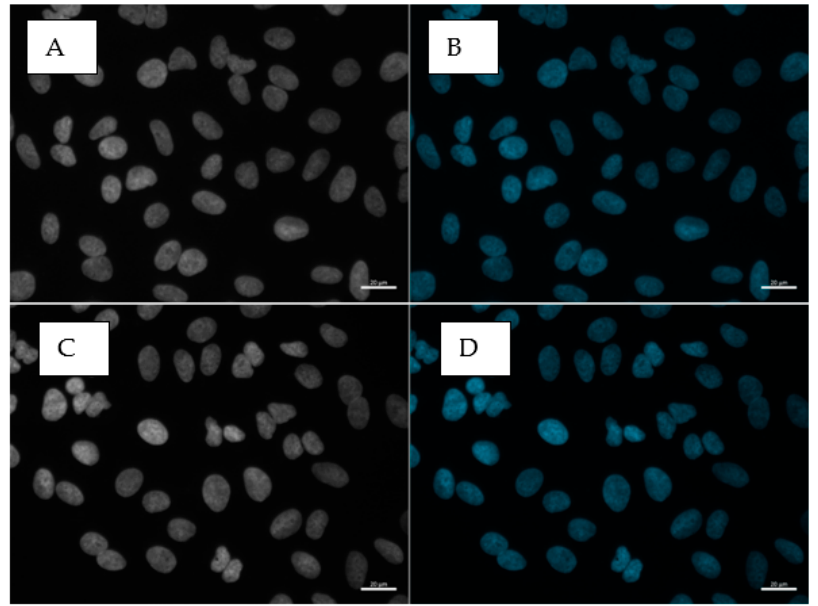
Figure A7. Hoechst stained A549 for mycoplasma screening. The absence of extranuclear cytoplas- mic staining confirm the absence of mycoplasma in the cultured A549 cells. Pictures are from two different passages: passage 10 is reported in Figure A6 ( A ) (tones of grey channel) and ( B ) (Hoechst channel), passage 19 is reported in Figure A6 ( C ) (tones of grey channel) and ( D ) (Hoechst